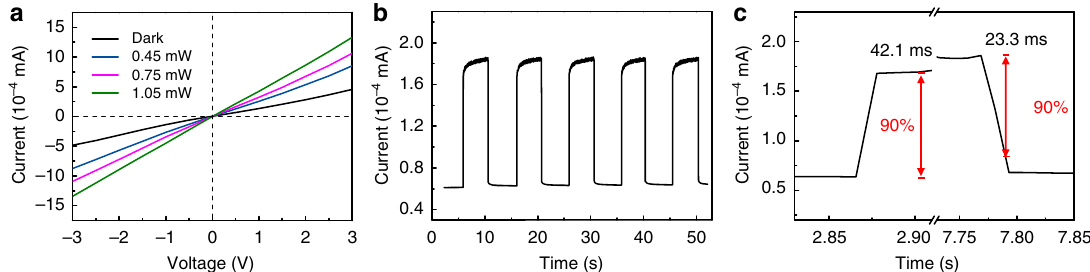
Fig. 6 Photodetector performance of Sn 0.5 W 0.5 S 2 /SnS 2 heterostructures. a I – V curves at different light intensity, b temporal photocurrent response and c a zoom-in view of the temporal photocurrent response of a photodetector based on Sn 0.5 W 0.5 S 2 /SnS 2 heterostructures. The light source used for all measurements was a 405 nm laser